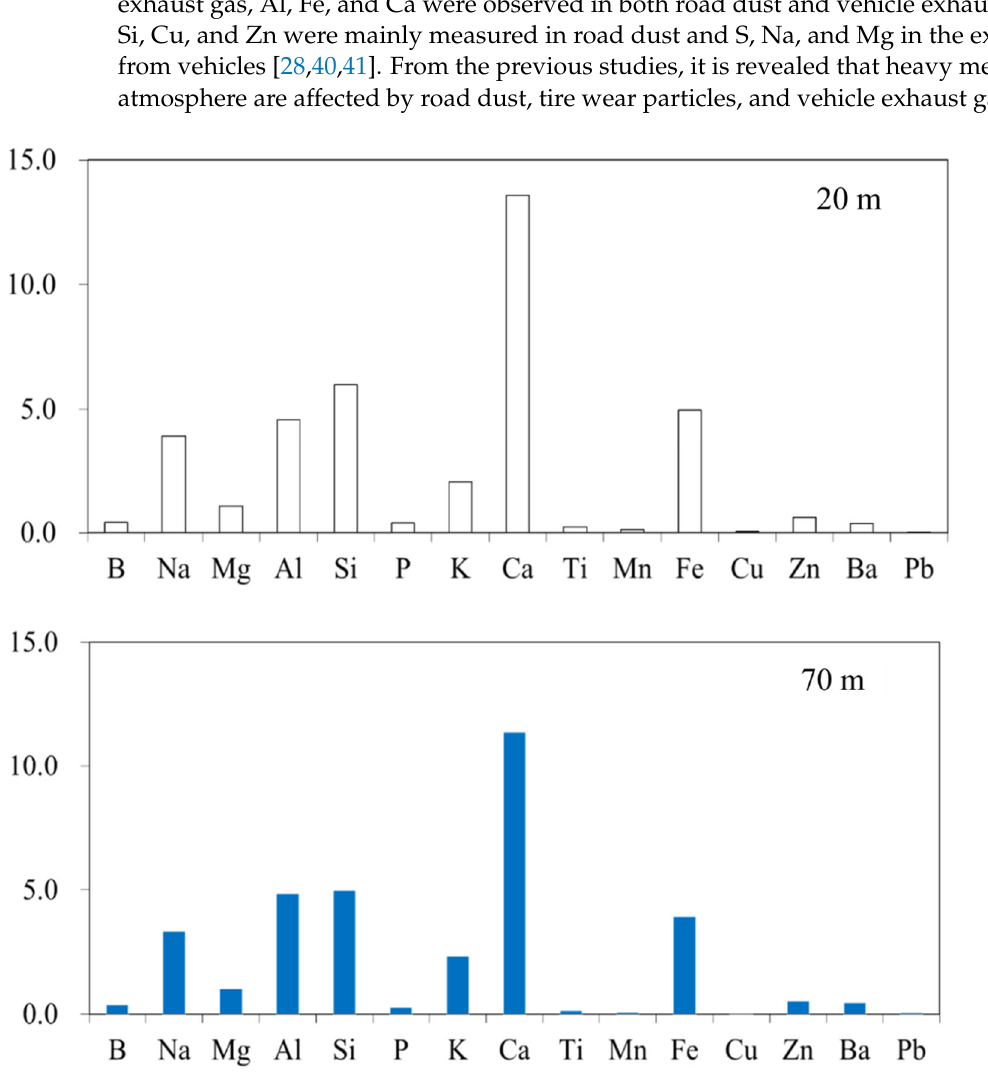
Figure 9. The distribution of metal components in the TSP sampled at 20 m and 70 m, respectively.